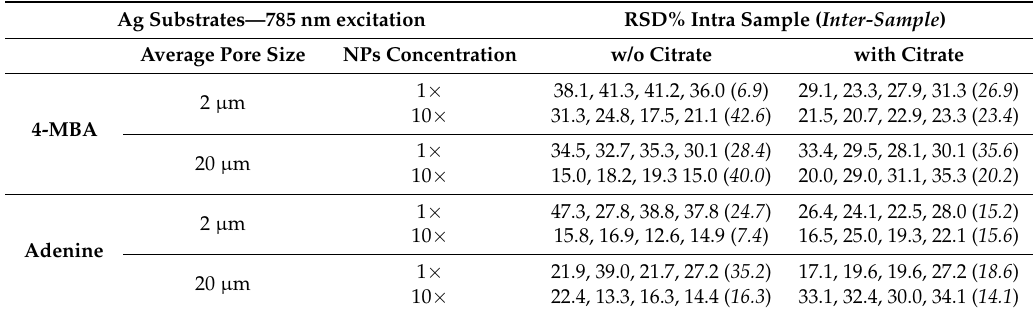
Table 3. Intra- and inter-sample Relative Standard Deviations (RSD) of the 4-MBA band area (1550~1615 cm − 1 ), and of the adenine band area (700~770 cm − 1 ), calculated from SERS maps for Ag substrates excited at 785